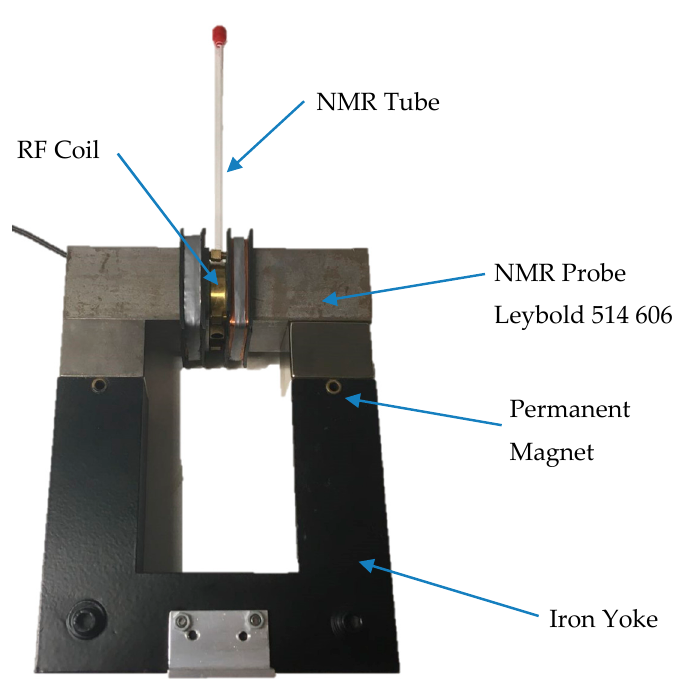
Figure 1. Photograph of closed Loop Magnet setup used for sensor measurements showing the permanent magnets, iron yoke and Leybold NMR Probe.